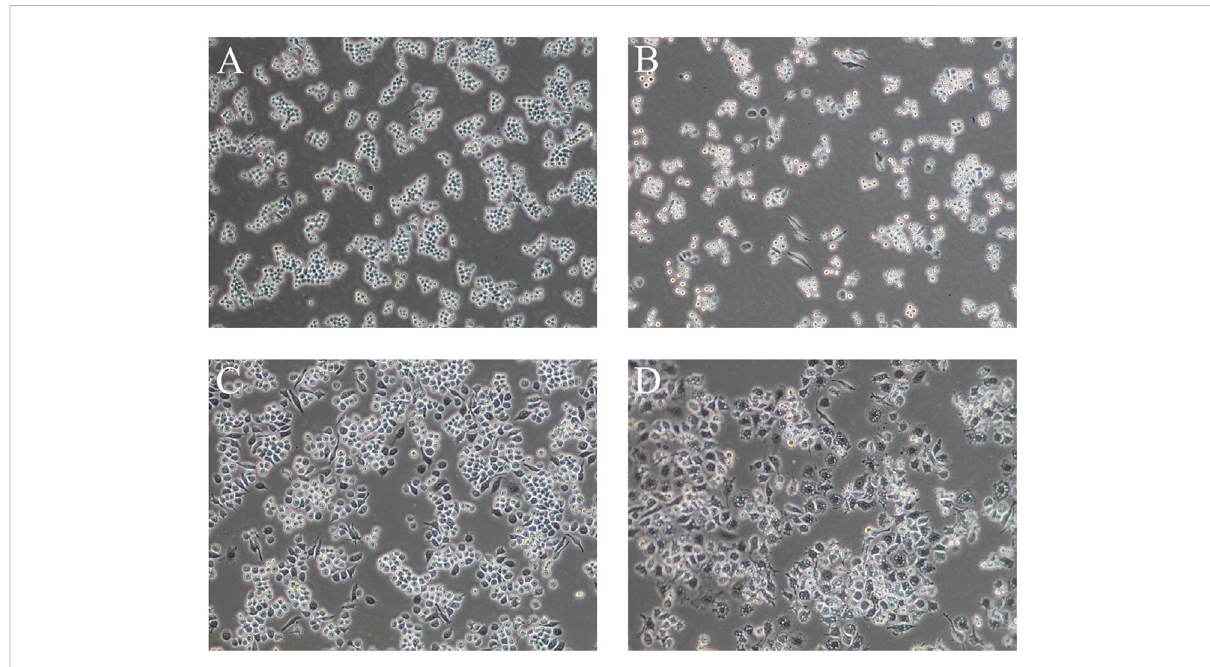
FIGURE 2 Cell morphology of LPS-induced RAW264.7 cells at different times (A) : normal cells, (B) 1 μ g/ml LPS-induced cells at 6 h, (C) 1 μ g/ml LPS- induced cells at 12 h, (D) 1 μ g/ml LPS-induced cells at 24 h)